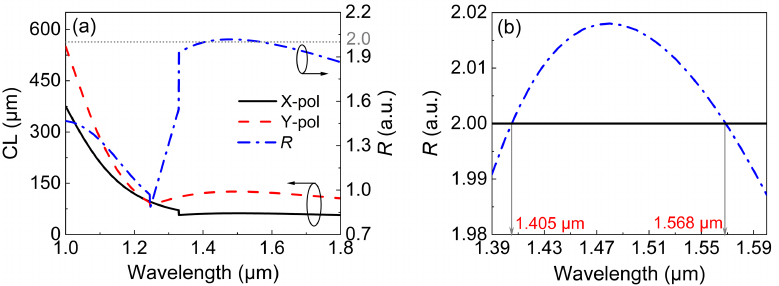
Figure 9. ( a ) The variations in CLX , CLY , and R with the wavelength for the optimized DCPCF. ( b ) Zooming in on R in the wavelength range of 1.39–1.6 µ